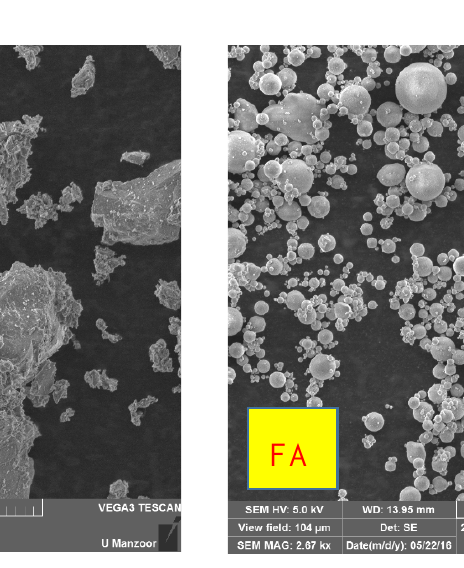
Figure 3. Materials in powder form as used in this study: cement (C); fly ash (FA); quarry dust (QD);